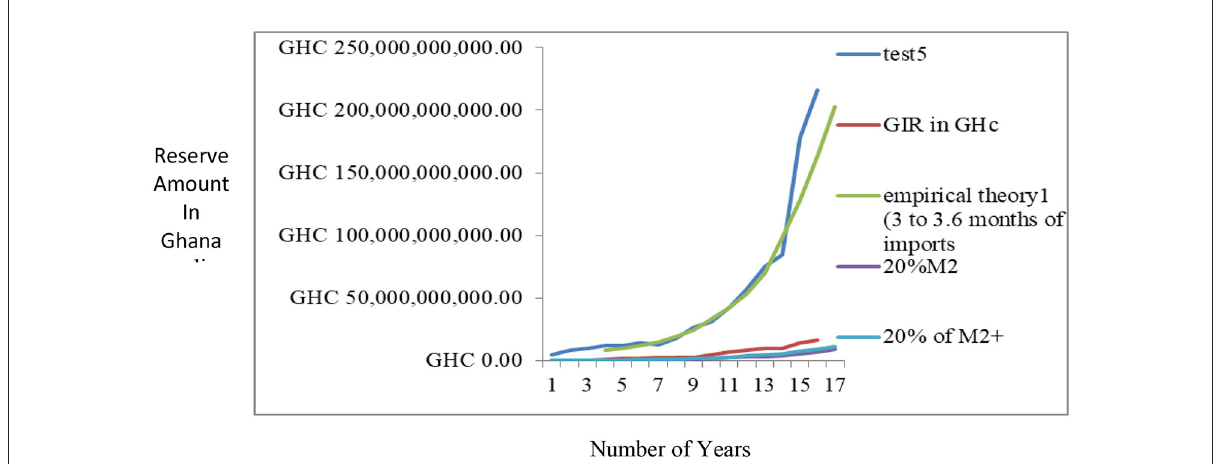
FIGURE6 Optimal Model (OPREM) compared to other empirical benchmarks (YEARLY ANALYSIS).